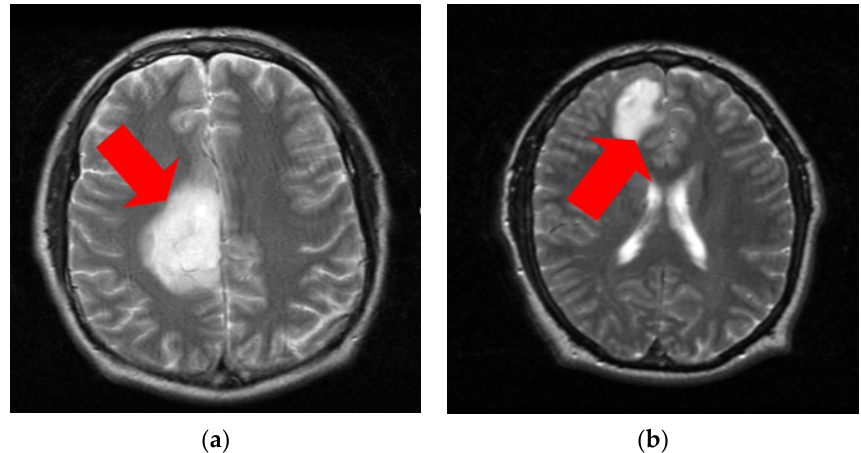
Figure 2. Gliomas of Grades II ( a ) and Grade III ( b ) as they appeared on brain magnetic resonance images from (The Cancer Imaging Archive) TCIA.